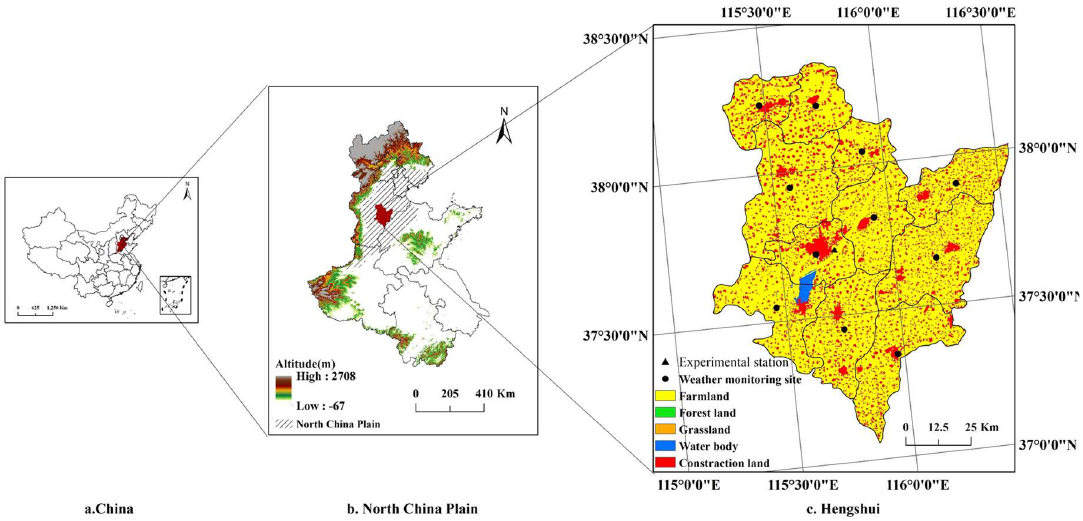
Figure 1. ( a ) Map of China ( b ) Topographic map of North China Plain ( c ) Land use of Hengshui in 2015